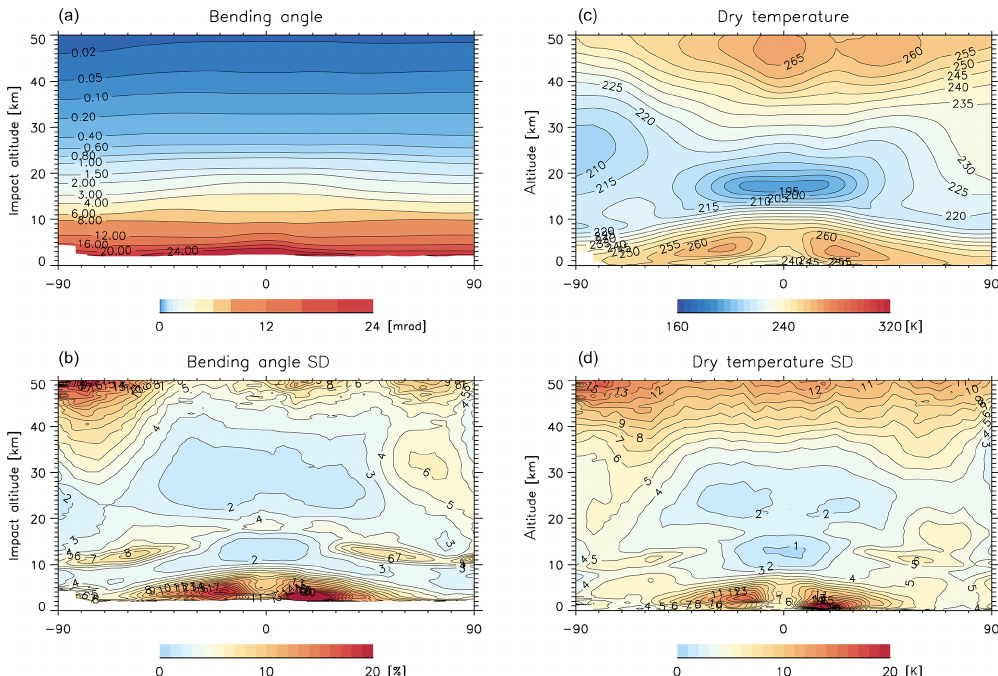
Figure 3. Zonally gridded monthly means and standard deviations for bending angle (a, b) and dry temperature (c, d) in April 2014. The monthly means were sampling-error corrected and include data from the Metop-A and Metop-B